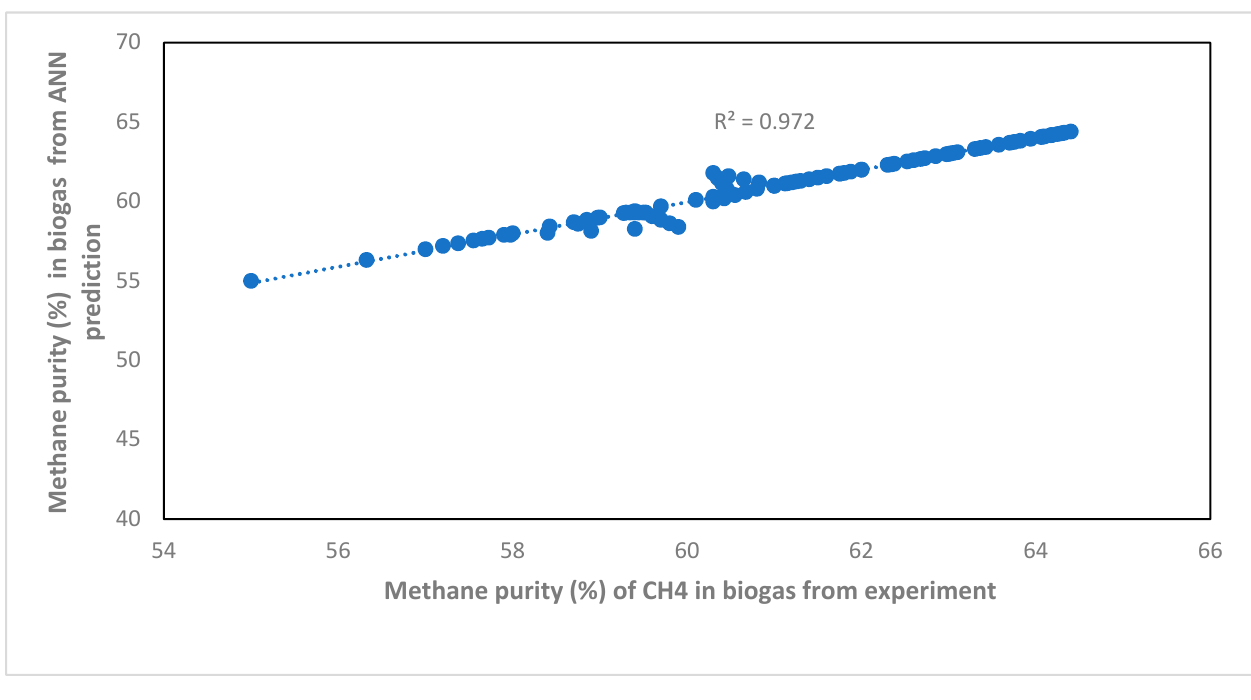
14 of 38 ( b ) Figure 3. ( a ) Correlation between experimental data and predicted value of COD removal. ( b ) Prediction value and measured data by ANN model for COD removal of anaerobic digestion.